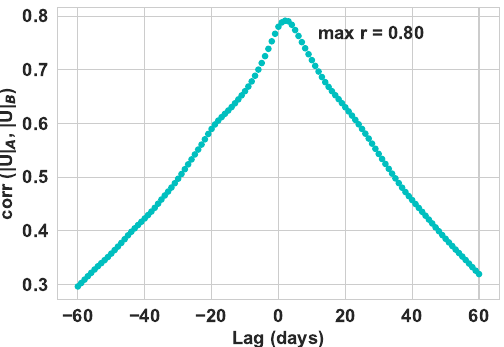
Figure 8. Lag correlation between magnitude of surface displacement at points A and